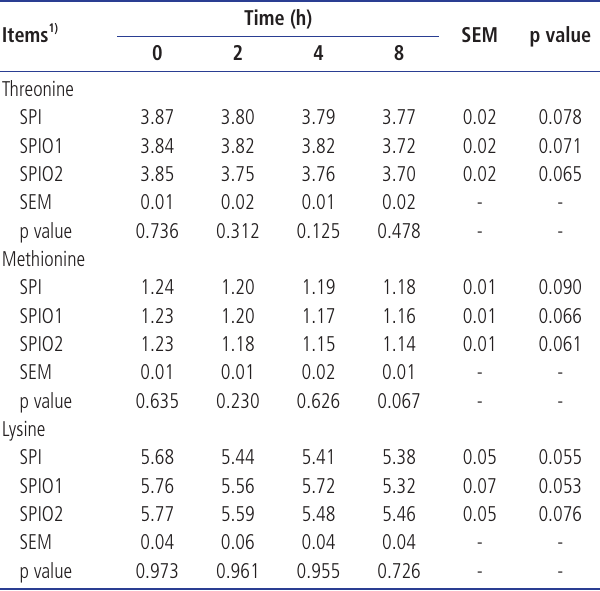
Table 3. Threonine, methionine and lysine of SPI heated with different soybean oil contents at 100°C (%, dry matter basis) Items 1)